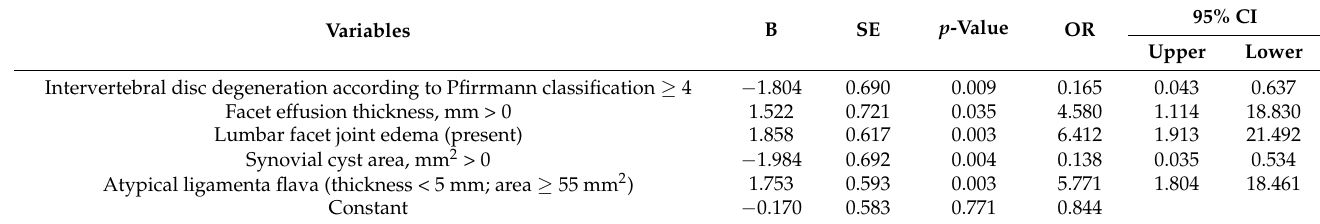
Table 5. Radiologic factors associated with